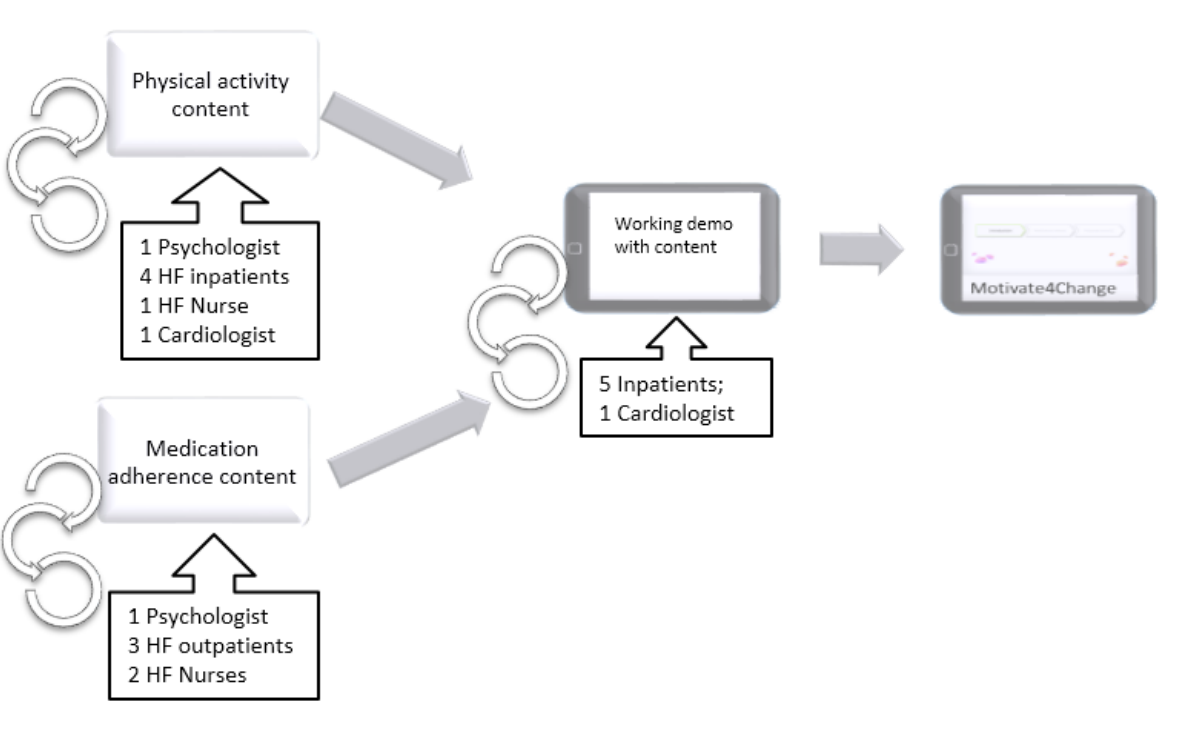
Figure 2. The iterative process of the intervention content development.